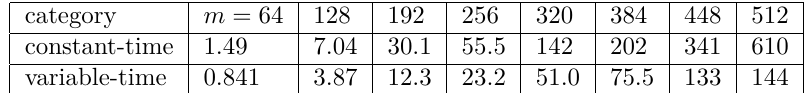
Table 16: Number of kilo cycles to evaluate the public-key with MQsoft , for m = n + v . We use a Skylake processor (DesktopS) with the avx2 instructions set. Turbo Boost is